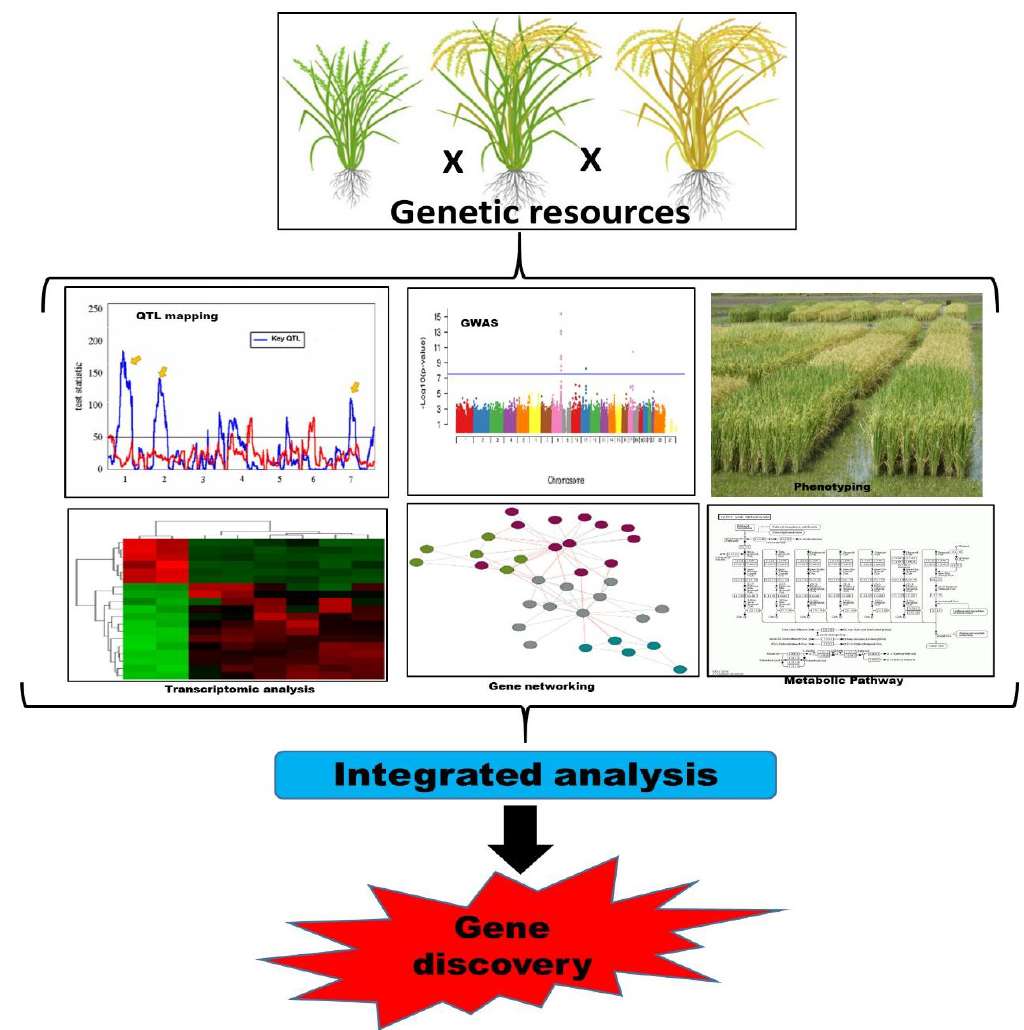
Figure 3. A schematic model for quantitative trait loci (QTL) mapping and the discovery of functional genes for a specific trait. To discover candidate genes for specific traits, a number of plant populations were used as a genetic resource. These resources were QTL mapping, GWAS (genome-wide association study), and transcriptomic analysis to allocate candidate genes for control of a specific character.